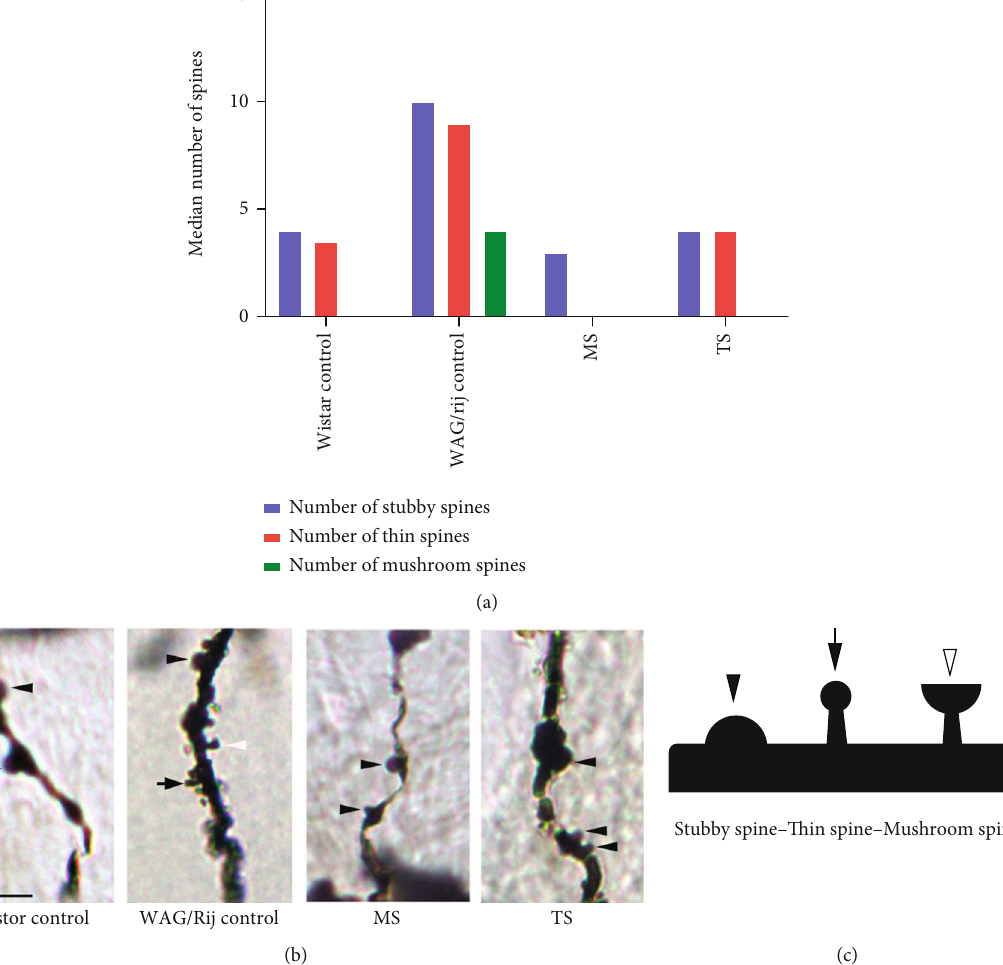
Figure 4: (a) Median number of spine subtypes in layer V pyramidal neurons of control Wistar, control WAG/Rij, maternally separated WAG/Rij, and tactile-stimulated WAG/Rij rats. (b) Photomicrographic (2000x) representation of di ff erent dendritic densities and dendritic spine types in four groups. The magni fi cations show examples of each dendritic spine type. (c) In the bottom, a schematic representation of each dendritic spine type is presented and matched with related arrows. Scale bar 5 μ m